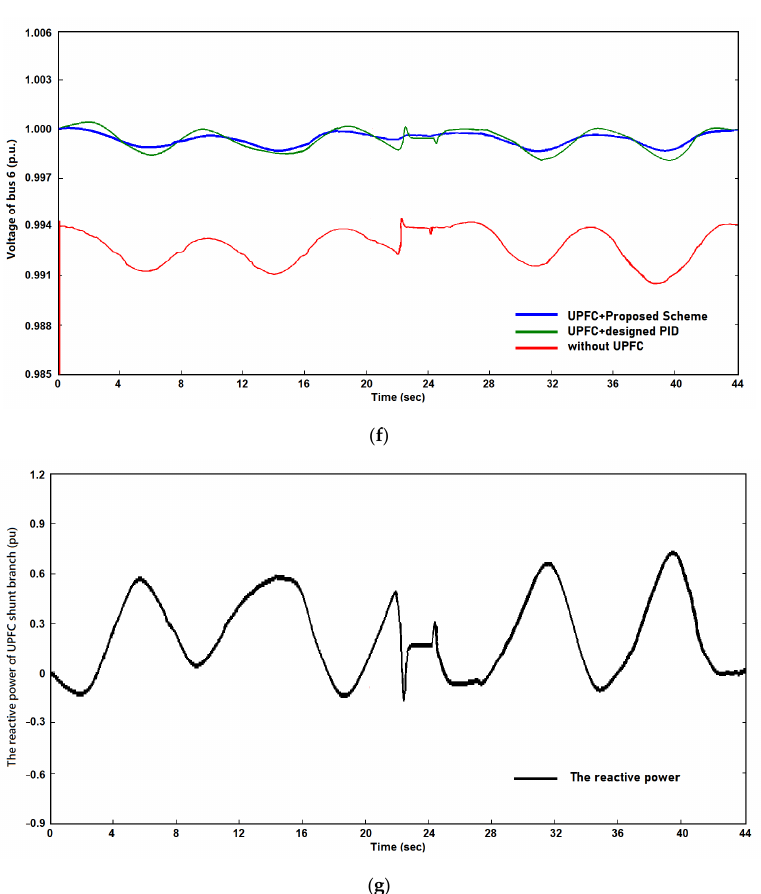
Figure 6. Transient responses of the proposed system with wind and wave speed changes: ( a ) Active power response of Line 2, ( b ) Reactive power response of Line 2, ( c ) Active power response of Line 1, ( d ) Reactive power response of Line 1, ( e ) Voltage of Bus 4, ( f ) Voltage of Bus 6, ( g ) Reactive power response of UPFC.